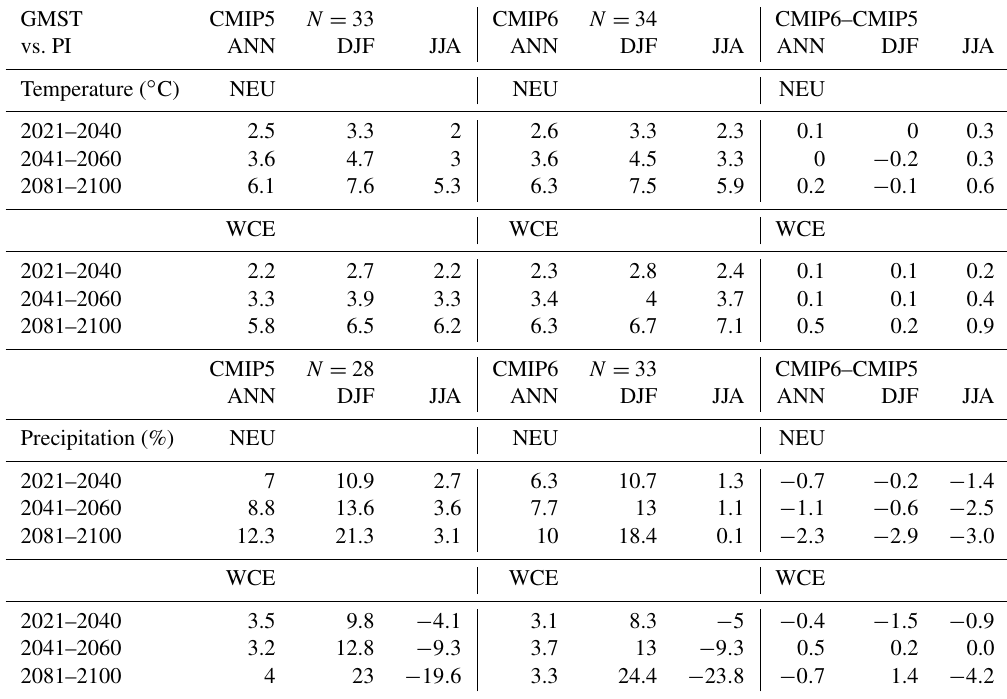
Table 7. As in Table 6 but with ensemble mean changes in temperature (degrees Celsius) and precipitation (percent) at selected future time slices (2021–2040, 2041–2060, and 2081–2100) compared to preindustrial (PI) conditions during 1850–1900. GMST CMIP5 N = 33 CMIP6 N = 34 CMIP6–CMIP5 vs. PI ANN DJF JJA ANN DJF JJA ANN DJF JJA Temperature ( ◦ C) NEU NEU